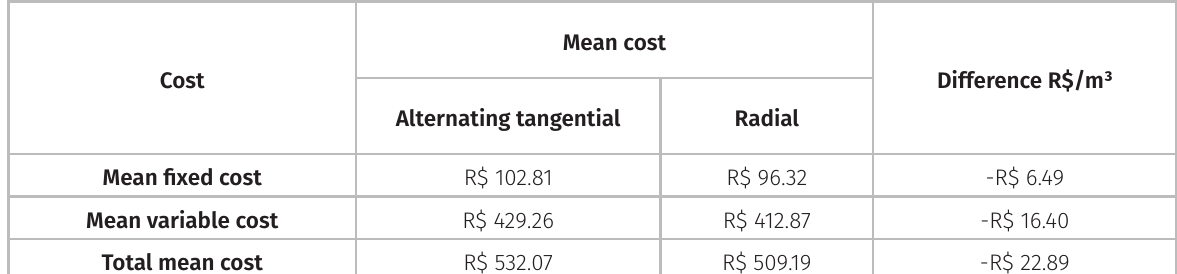
Table VI. Mean costs of sawn wood production of Eucalyptus for the alternating tangential sawing pattern and radial sawing